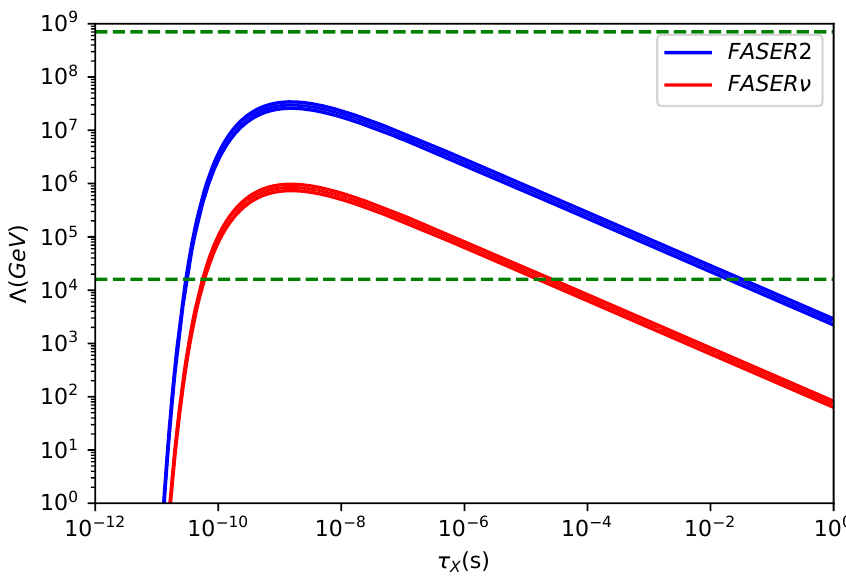
Figure 2 . Lower bound on (cid:3) versus the X lifetime. The red band shows the bound by the FASER (cid:23) setup in the run III of LHC during 2021{2023 with a luminosity of 150 fb (cid:0) 1 at a center of mass p energy of colliding protons of s = 14 TeV. The blue band shows the bound by the FASER2 setup in the high luminosity run of LHC during 2026{2035 with a luminosity of 3000 fb (cid:0) 1 . We have taken m X 0 = 3 GeV and m X = 1 GeV. The gluon distribution function is taken from [35]. The bands re(cid:13)ect the uncertainties on the gluon distribution function especially at low momentum fractions. The horizontal lines show the allowed range for (cid:3)